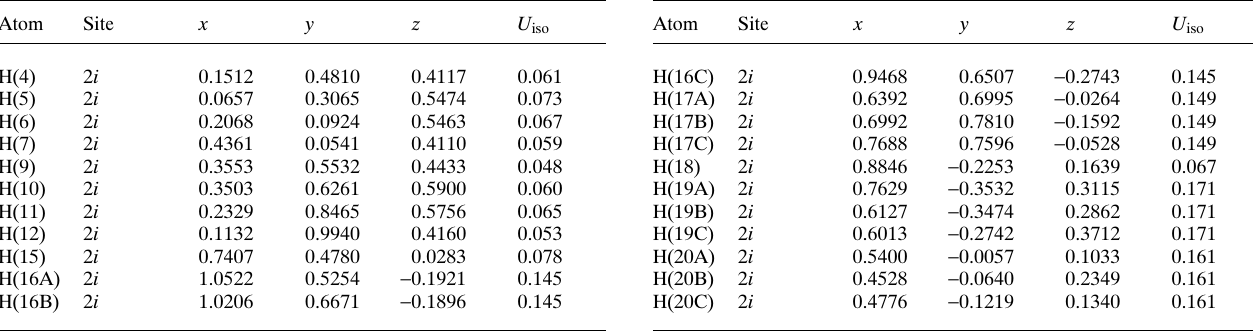
Table 2. Atomic coordinates and displacement parameters (in Å 2 ) . Table 2. Continued